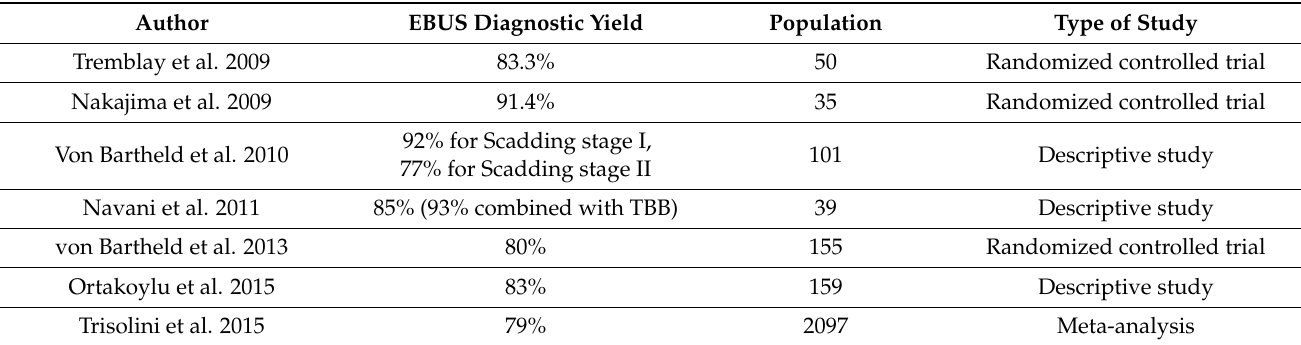
Table 2. Resumptive table of diagnostic yield of EBUS-TBNA in